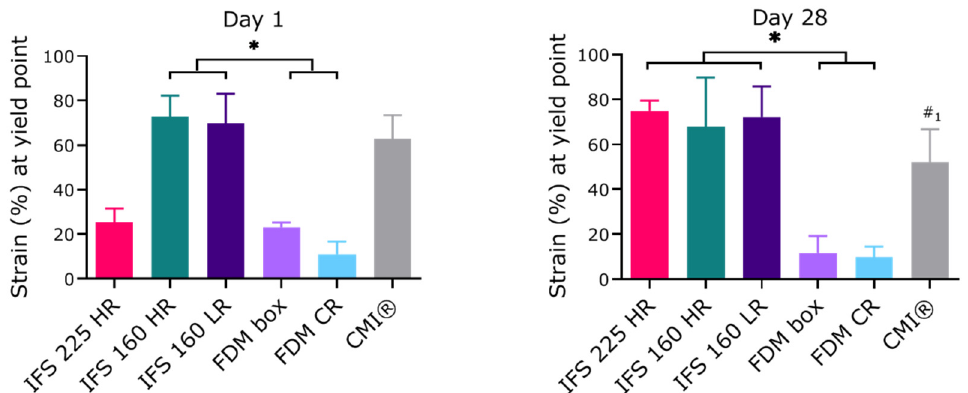
Figure A2. Strain (%) at yield point for all scaffolds at day 1 and day 28. *, p < 0.05; # 1 p < 0.05 compared to all groups except IFS 160 HR. Abbreviations; 160: 160 µm, 225: 225 µm, CMI ® : Collagen Meniscus Implant ® , IFS: inter fibre spacing, HR: high ratio of radial fibres, LR: low ratio of radial fibres, FDM: fused deposition modelling, CR: circumferential and radial fibres, Box: box-structure.